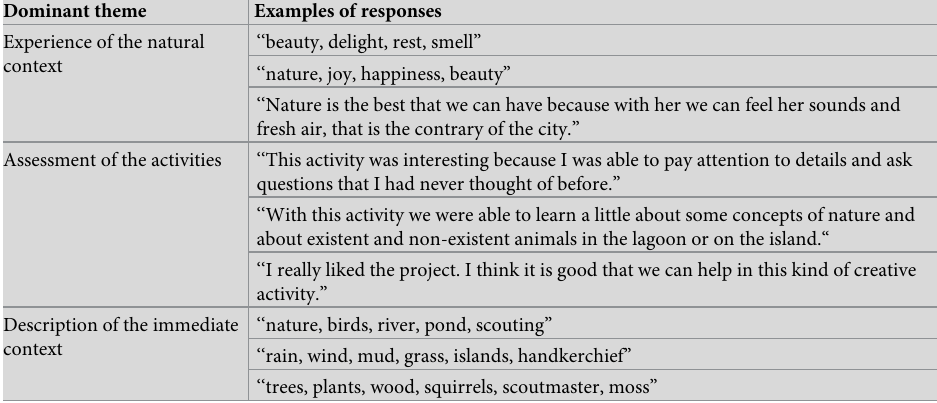
Table 5. Illustrative responses from the final free, open-ended activity according to three types of ‘‘dominant themes”, inspired by Litfin [1995]. Dominant